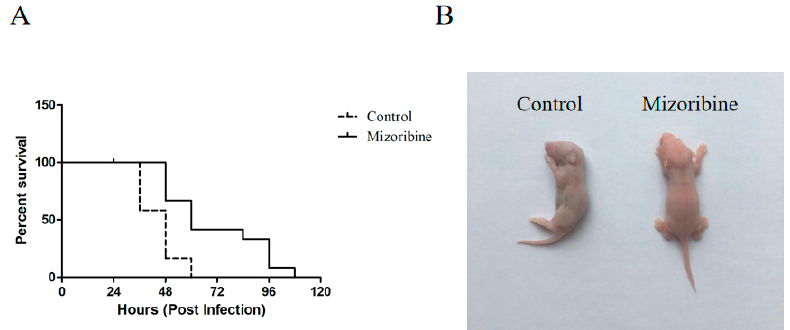
Figure 6. Mizoribine treatment prolonged the survival time of FMDV-infected mice. ( A ) Survival rates of the FMDV-infected mice treated with the placebo or mizoribine (50 µ g) were recorded at five days